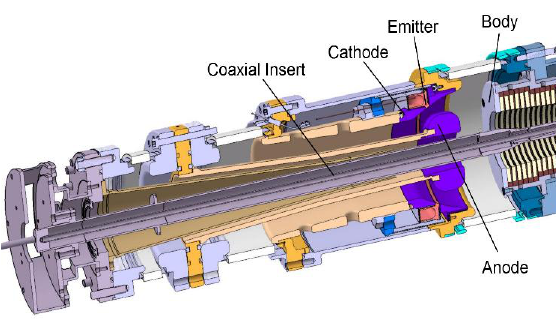
Fig. 5. Sketch of the already manufactured inverse magnetron injection gun (IMIG); the total length of the displayed section is approximately 700